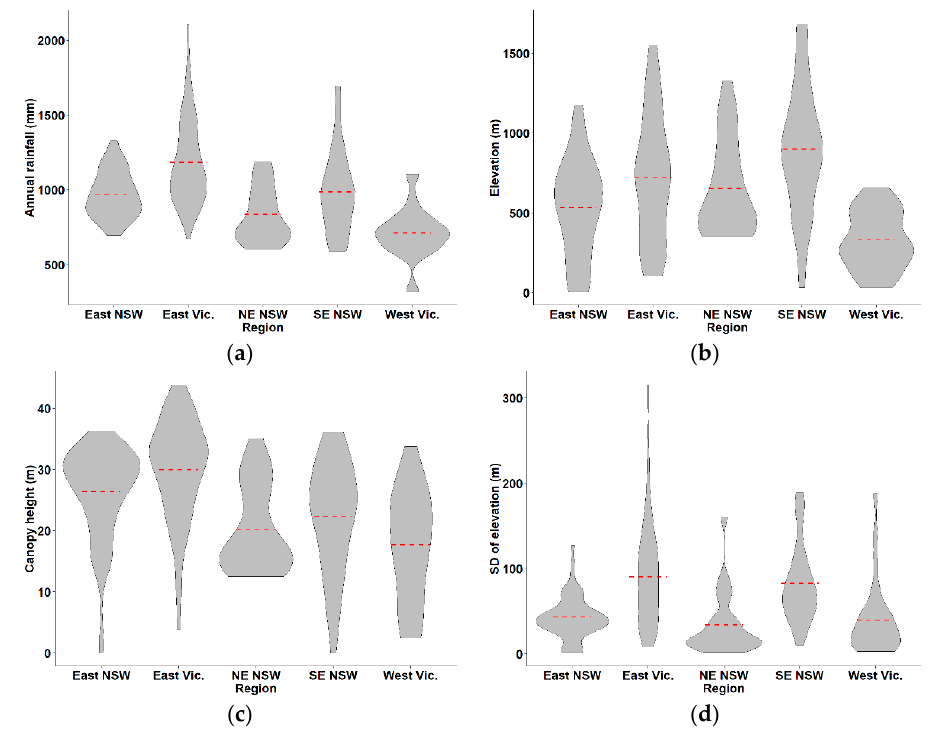
Figure 11. Violin plot comparison of regionally summarized mean source fire rainfall ( a ), mean source fire elevation ( b ), mean source fire canopy height ( c ), and source fire standard deviation of elevation ( d ) values. The red dotted line is the mean group value.